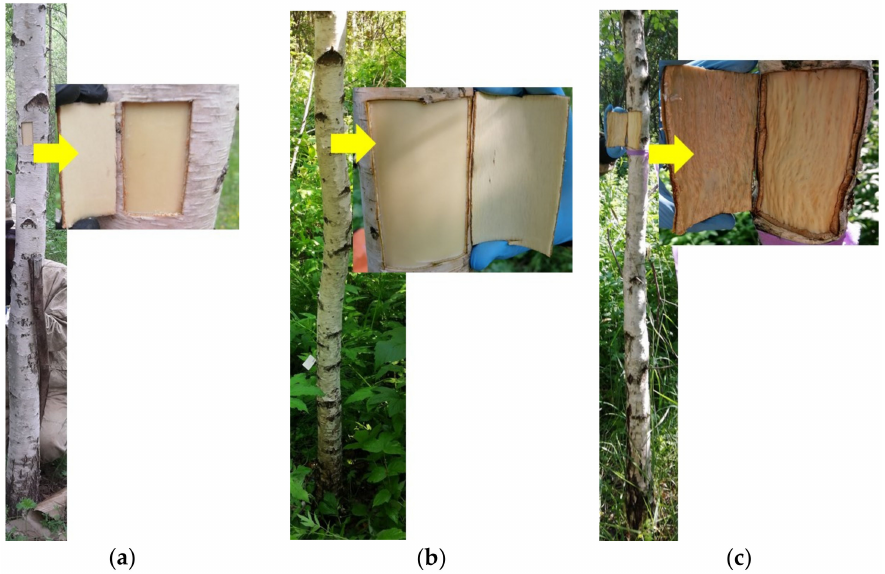
Figure 11. The trunk, debarked wood surface, and inner bark surface of B. pendula var. pendula ( a ), non-figured ( b ), and figured ( c ) B. pendula var. carelica